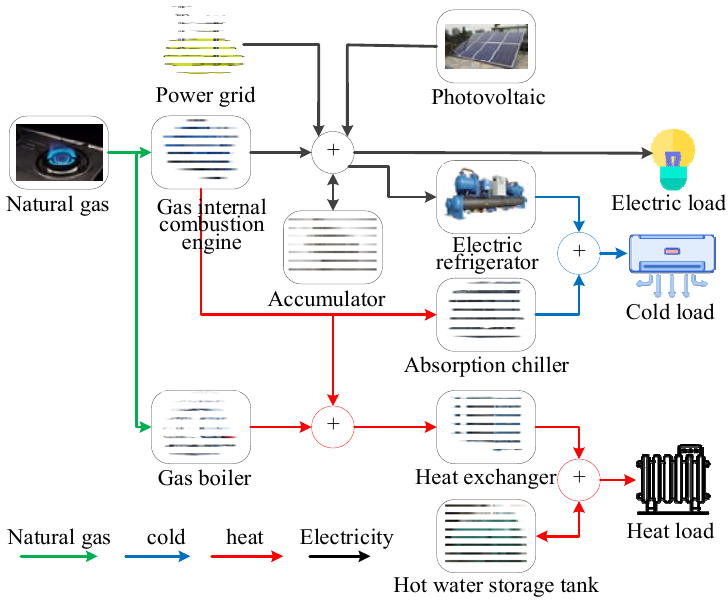
Figure 8. CCHP type microgrid structure diagram.